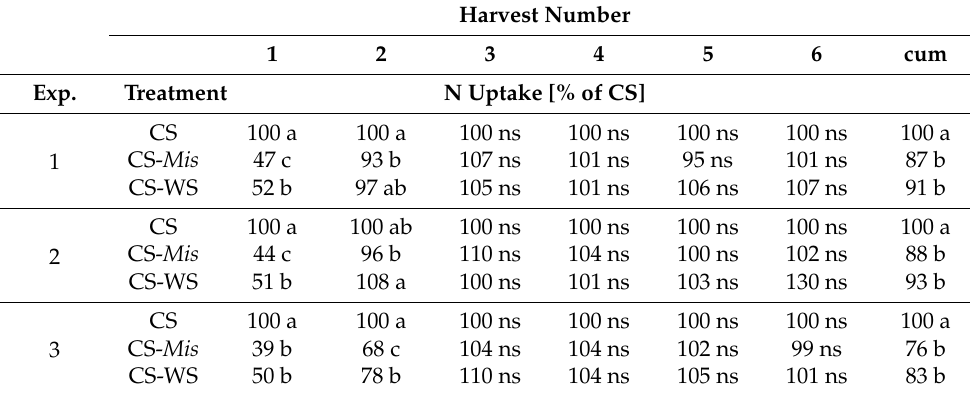
Table 7. Percentage of N uptake of the two mixtures (CS- Mis = Cattle Slurry- Miscanthus (5 kg to 1 kg); CS-WS = Cattle Slurry-Wheat Straw (8.5 kg to 1 kg)) to N uptake of cattle slurry (CS), at the time of each harvest and cumulatively (cum). Listed for experiment (exp.) 1,2 and 3, respectively. Different letters within a column and within each experiment number show significant differences. One-way ANOVA; p < 0.05; ns = not significant; n = 5. Harvest